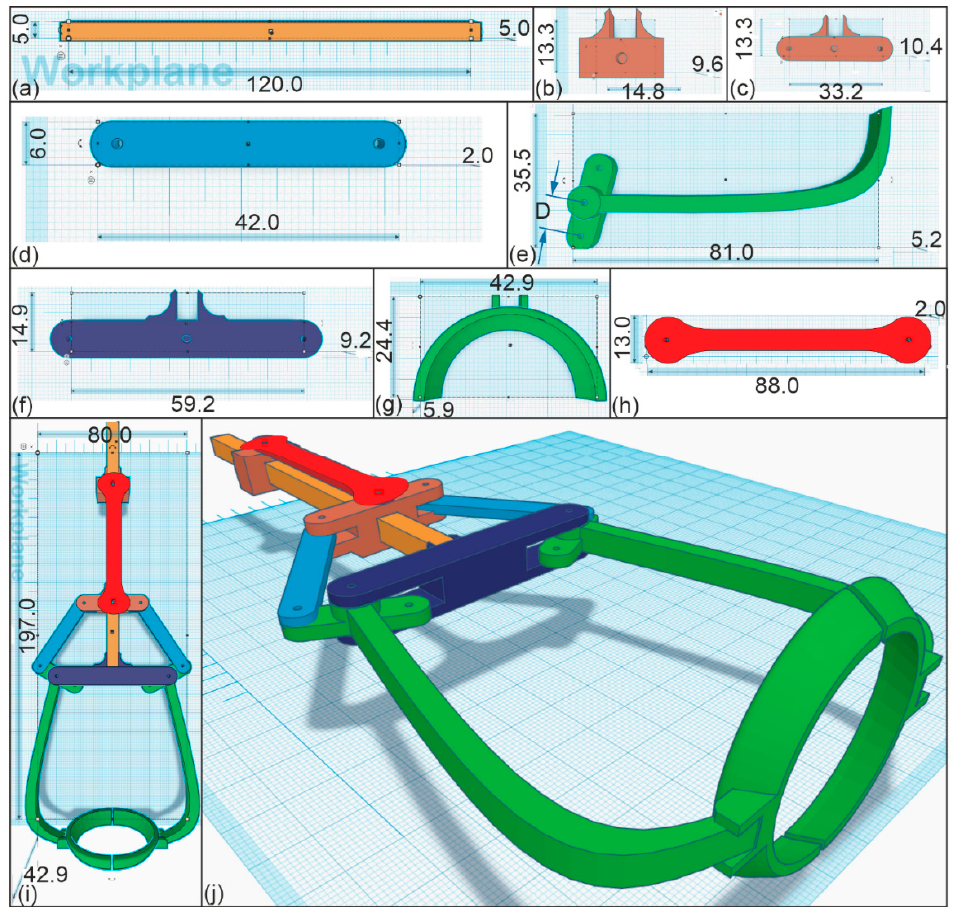
Figure 9. Technical drawing of a gripper: ( a ) main part; ( b ) upper actuator holder; ( c ) lower actuator-and linkage holder; ( d ) linkage bar; ( e ) gripper arm; ( f ) gripper holding part; ( g ) egg holder; ( h ) actuator element; ( i ) top view of assembled gripper arrangement; and ( j ) isometric view of gripper system. All data are provided in mm.